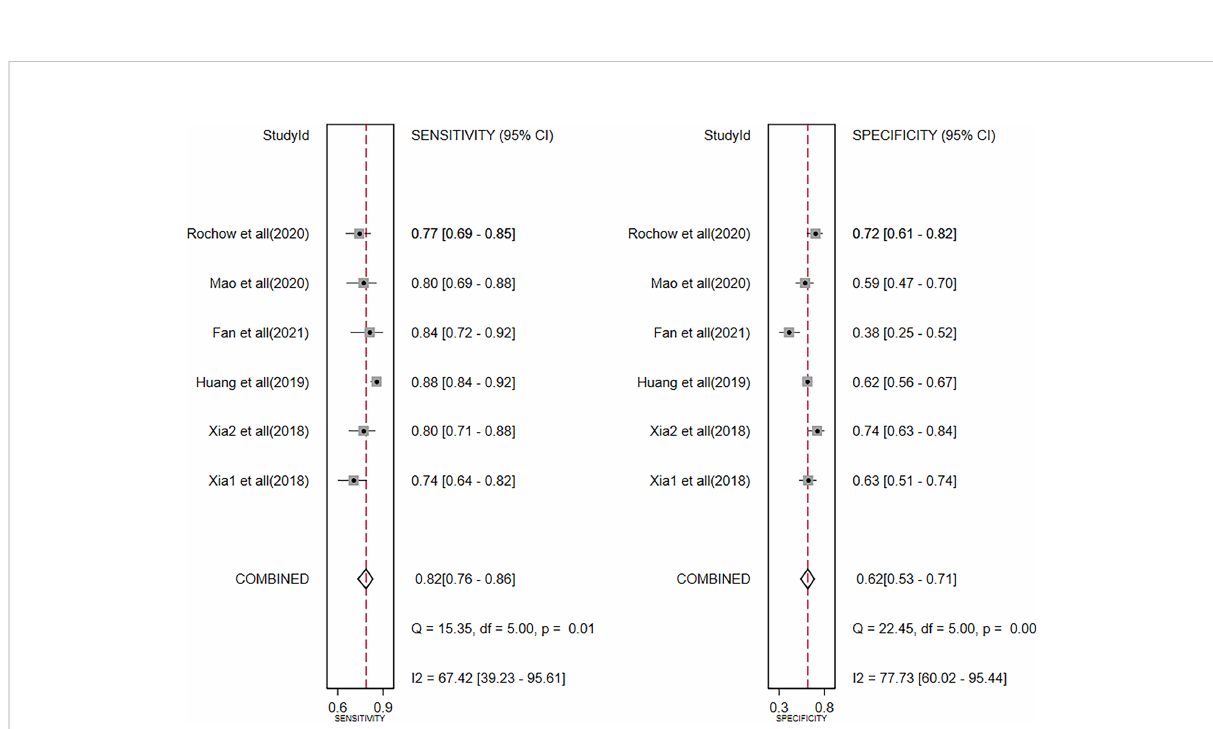
FIGURE 3 Forest plots of summary sensitivity and speci fi city to illustrate the diagnostic value of circRNAs for PCa. circRNAs, circular RNAs; PCa, prostate